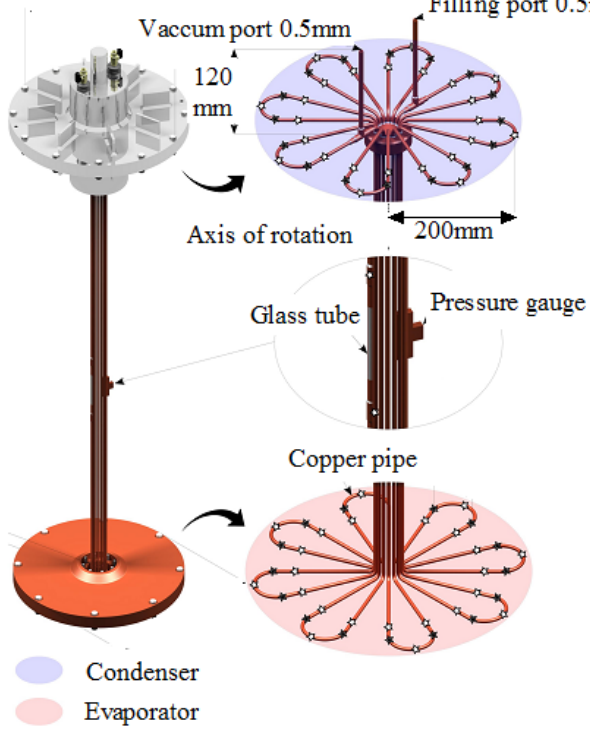
Figure 5. Rotating flower PHP [66]. Czajkowski et al.